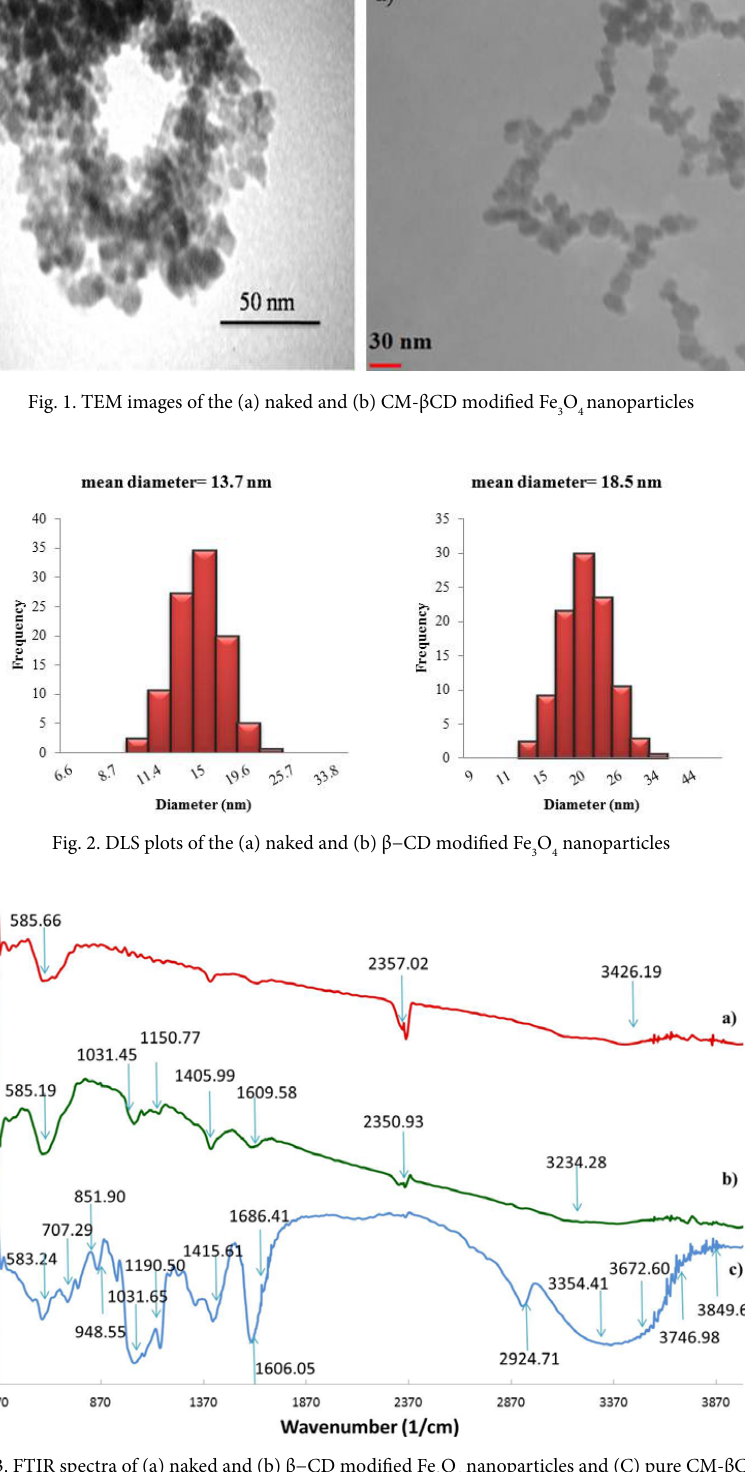
Fig. 3. FTIR spectra of (a) naked and (b) β−CD modified Fe Fig. 3 FTIR spectra of (a) naked and (b) β− CD modified Fe 3 O 4 nanoparticles and